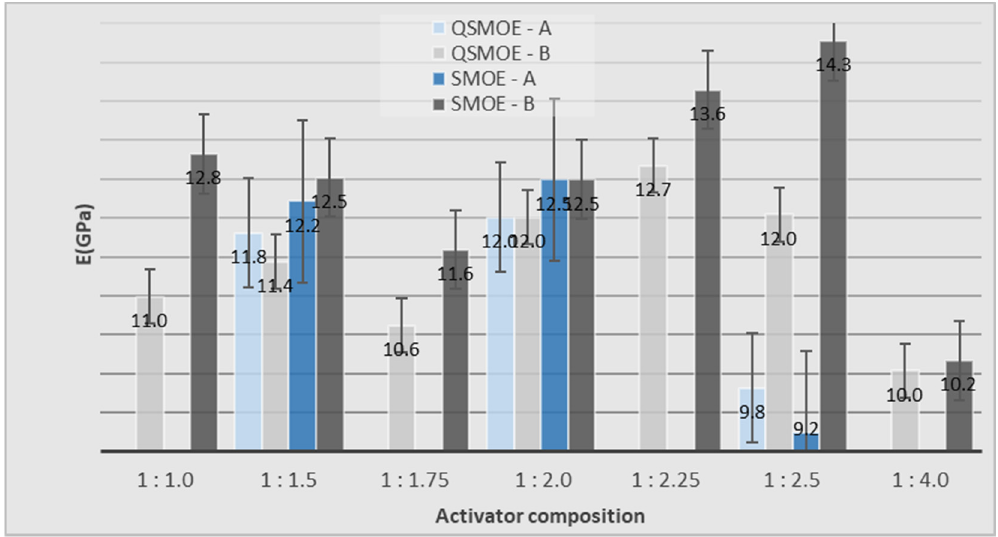
Figure 4. Quasi-static and static modulus of elasticity (QSMOE/SMOE) for Type A and Type B mixes.